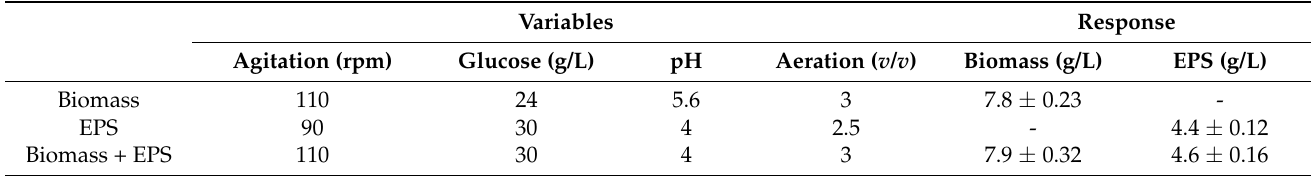
Table 6. Verification of model with optimised